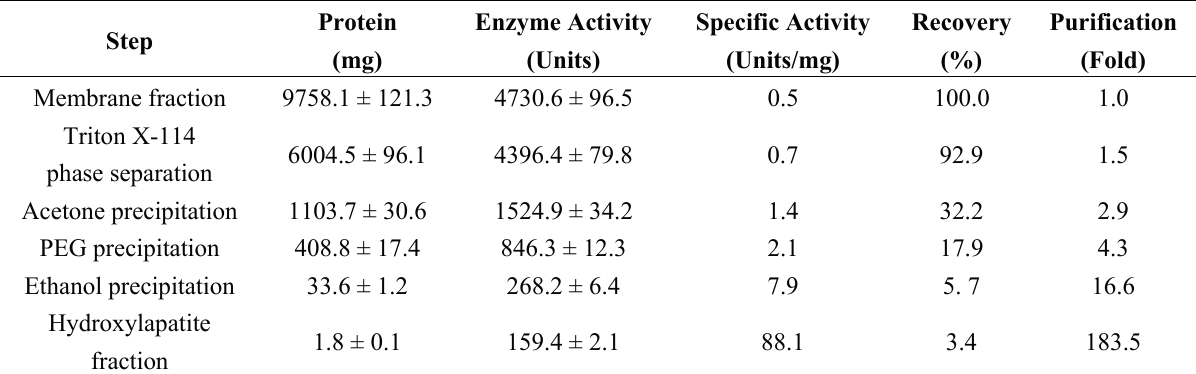
Table 1. Summarization of the GlcDH purification from A. globiformis